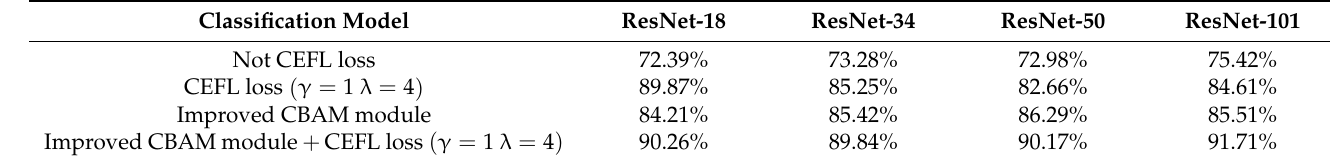
Table 11. Recall rates for each classification model.